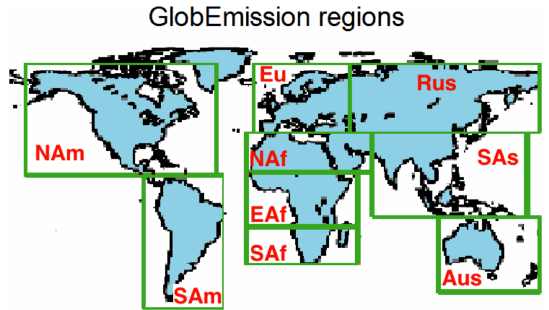
Figure 3. Geographical extent of the GlobEmission regions. Adapted from GlobEmission (https://www.globemission.eu/, last access: 18 January